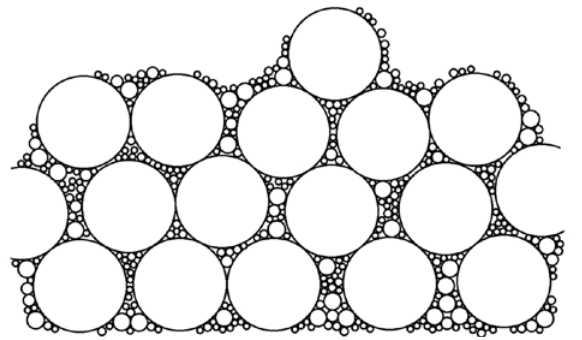
Figure 9. Generally larger particles form weaker gels. However, mixtures of large and small particles form very strong dense gels. The infill ‘necking’ and silanol linkages are not so well developed between larger particles. Smaller intergranular particles in the inter- stices act as strong ‘bridges’ linking the whole into a denser mass. [From Iler 2 , 1979, p. 372].